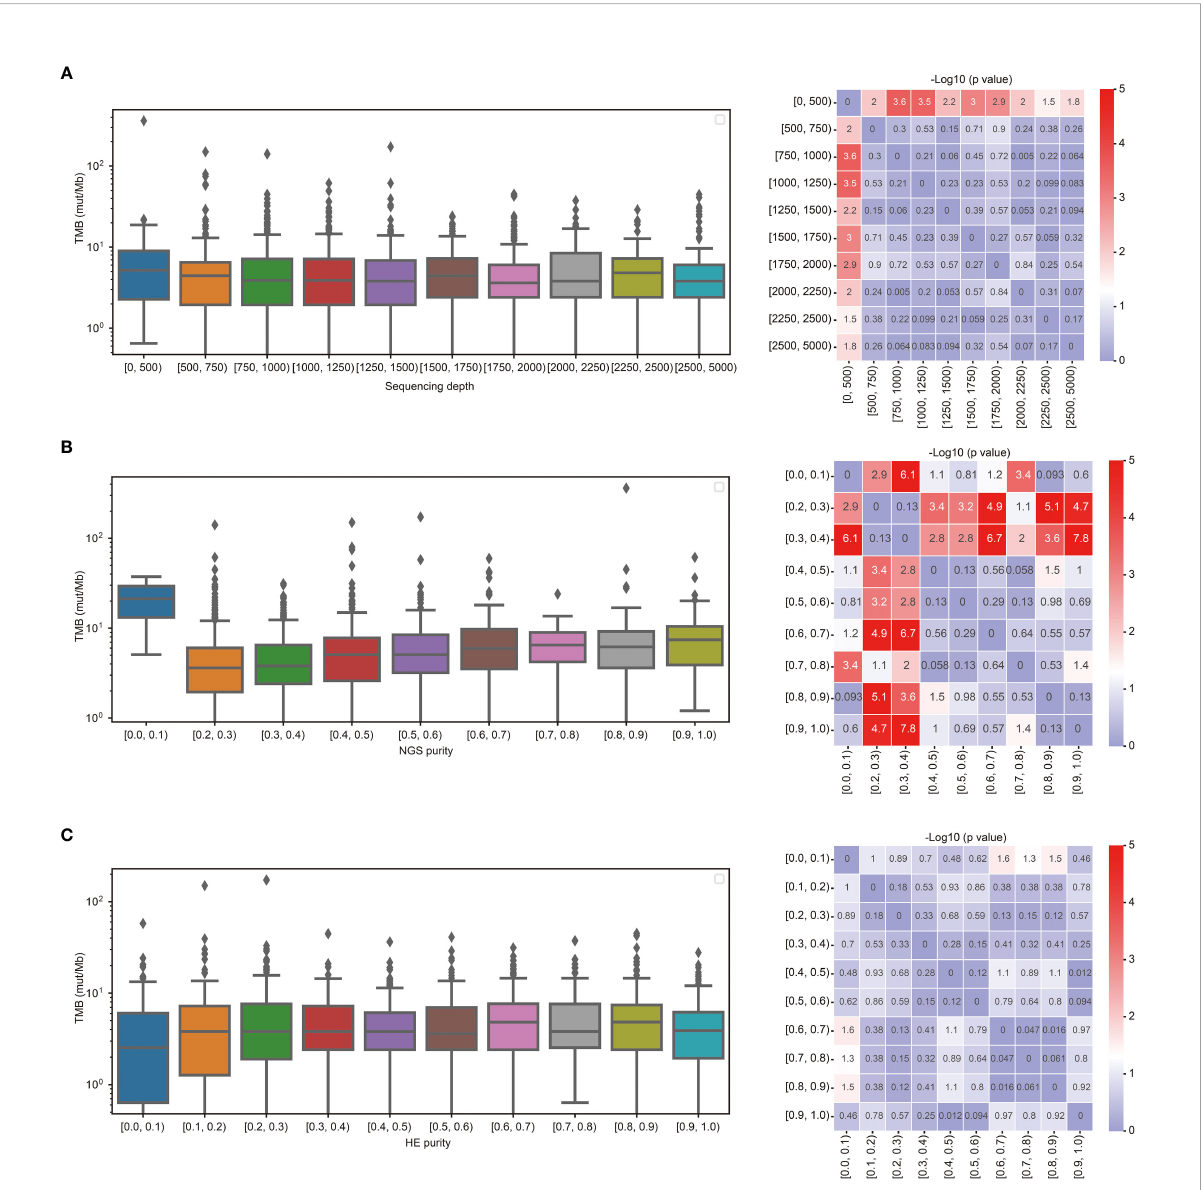
FIGURE 2 TMB calculation was affected by the sequencing depth and tumor purity. (A) Comparison of TMB between different sequencing depths. (B) Comparison of TMB between different purities estimated by NGS. (C) Comparison of TMB between different purities estimated by HE